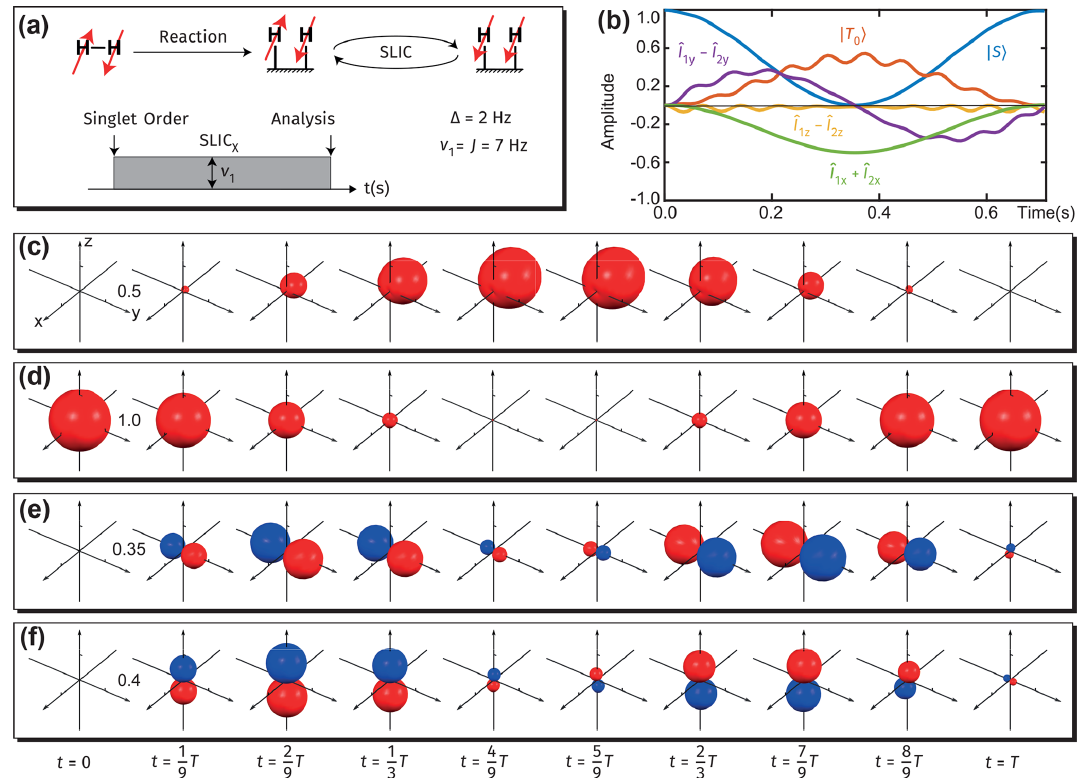
√ 2 /(cid:49) . (a) Scheme of the (cid:17) (cid:16) (cid:16) (cid:17) (1 , 0) (1 , 0) ; (f) . Note (cid:99) ZQ (cid:99) ZQ π 0 , 0 , 0 ˆ n ˆ n 2